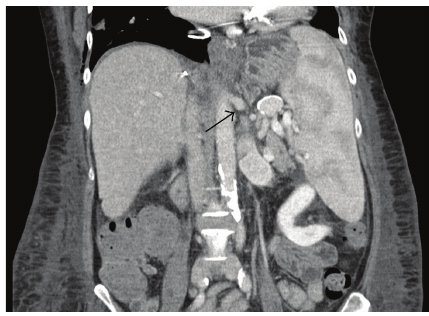
Figure 4: Postoperative CT imaging (day 47) showing in axial form the thrombosis of the left renal vein